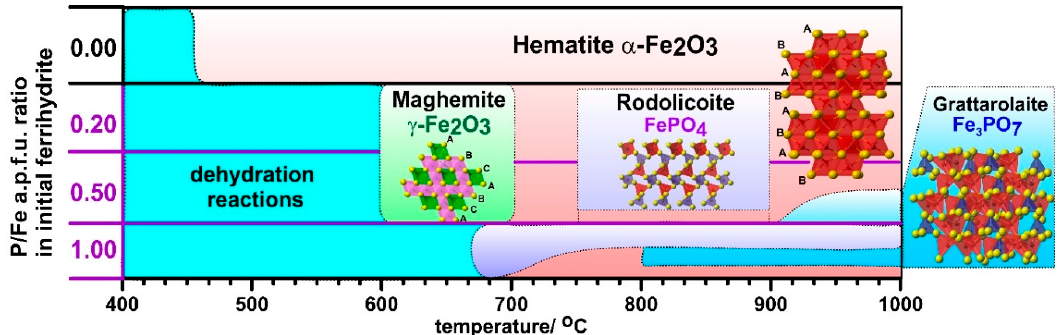
Figure 10. Schematic presentation of temperature ranges of phase stability during thermal transformations of P-doped ferrihydrite.